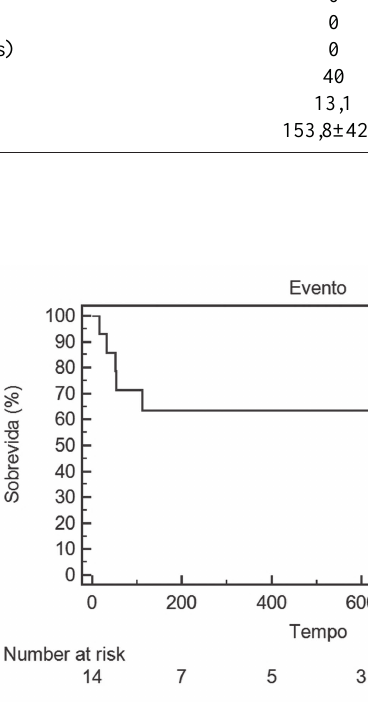
Fig. 1 - Curva de Kaplan Meyer.